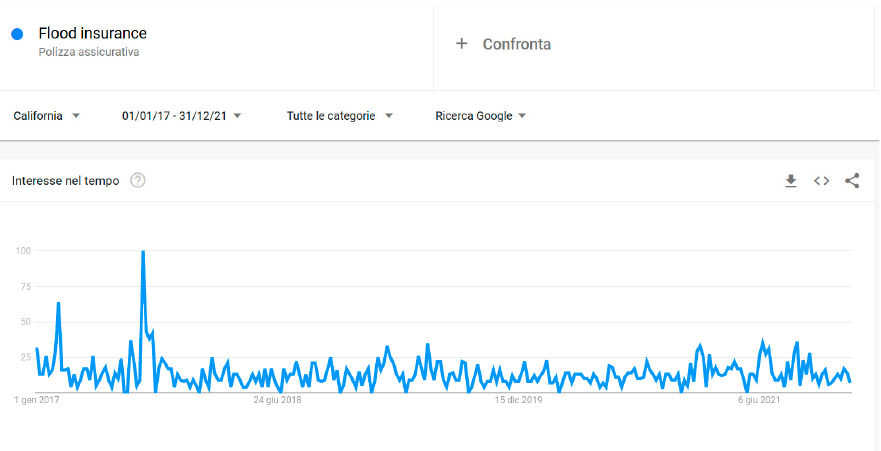
Figure 7. Search results (screenshot) for GT “flood insurance” topic in California during the time span of five years (2017–2021). Due to the time window length, search volumes are plotted weekly. The highest peak (100) was recorded in the week 27 August–2 September 2017, during or in the aftermath of Hurricane Harvey landfall. However, according to what we noticed for online attention in EQI and EQ, the searches in flood insurance started reasonably at the beginning of the week, in close temporal relationship with the occurrence of flooding.